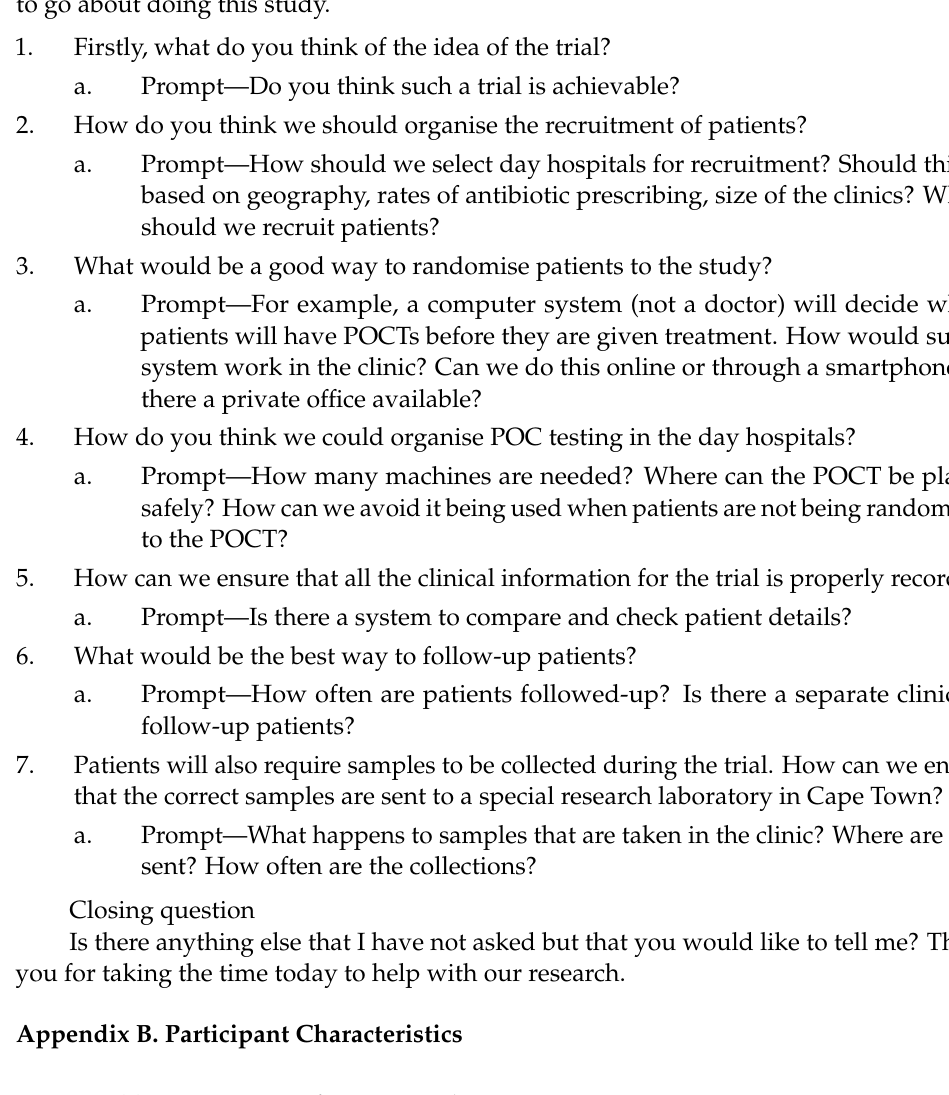
Table A1. Summary of participant